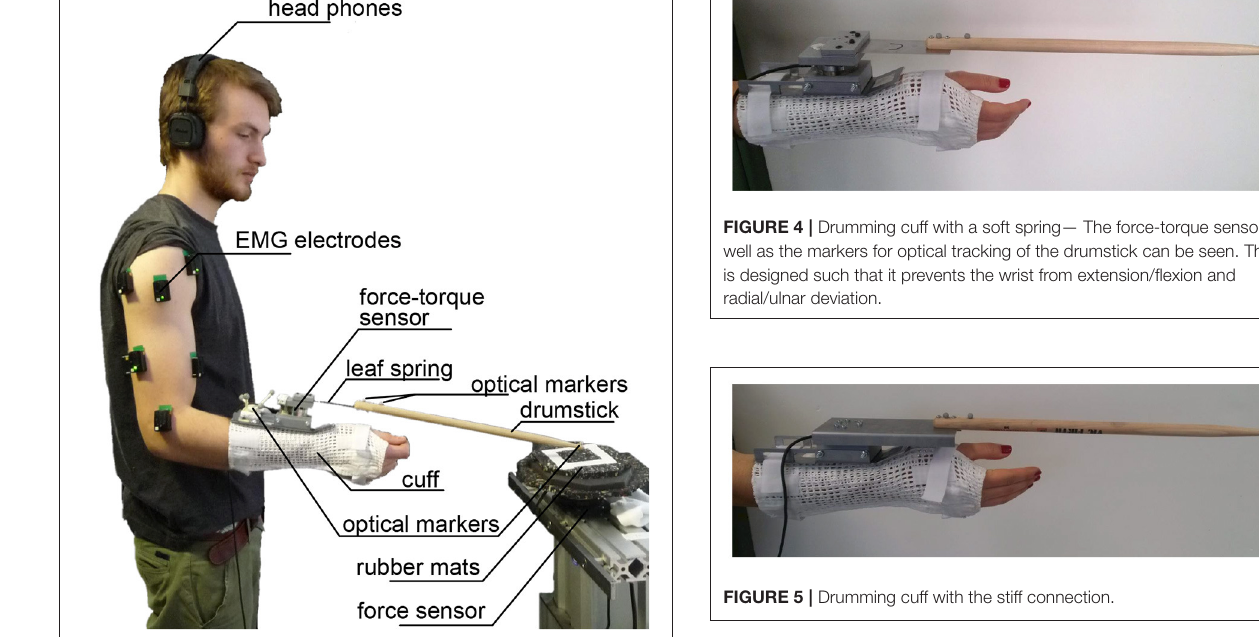
torque sensor fixed on a table (measurement range: F x / y =